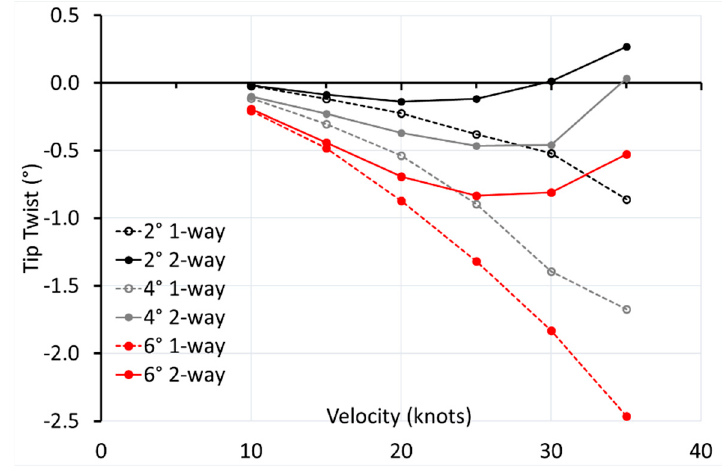
Figure 8. Tip twist (negative = wash-in = increased AoA) vs. velocity.